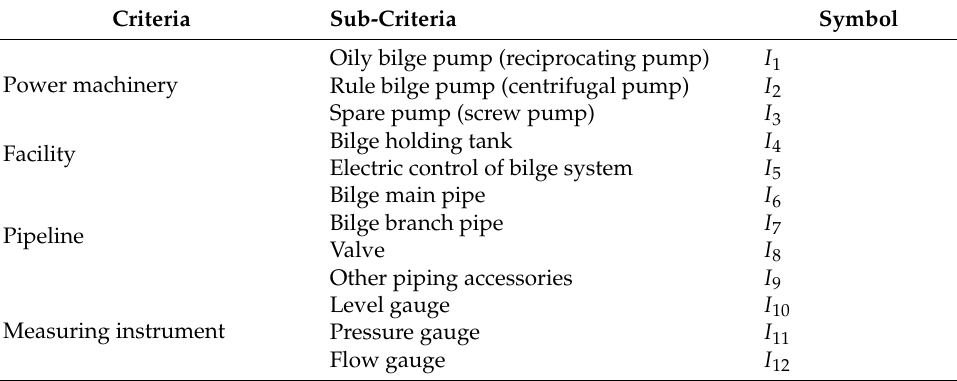
Table 6. Risk factors of the VISTA cruise ship’s bilge system.